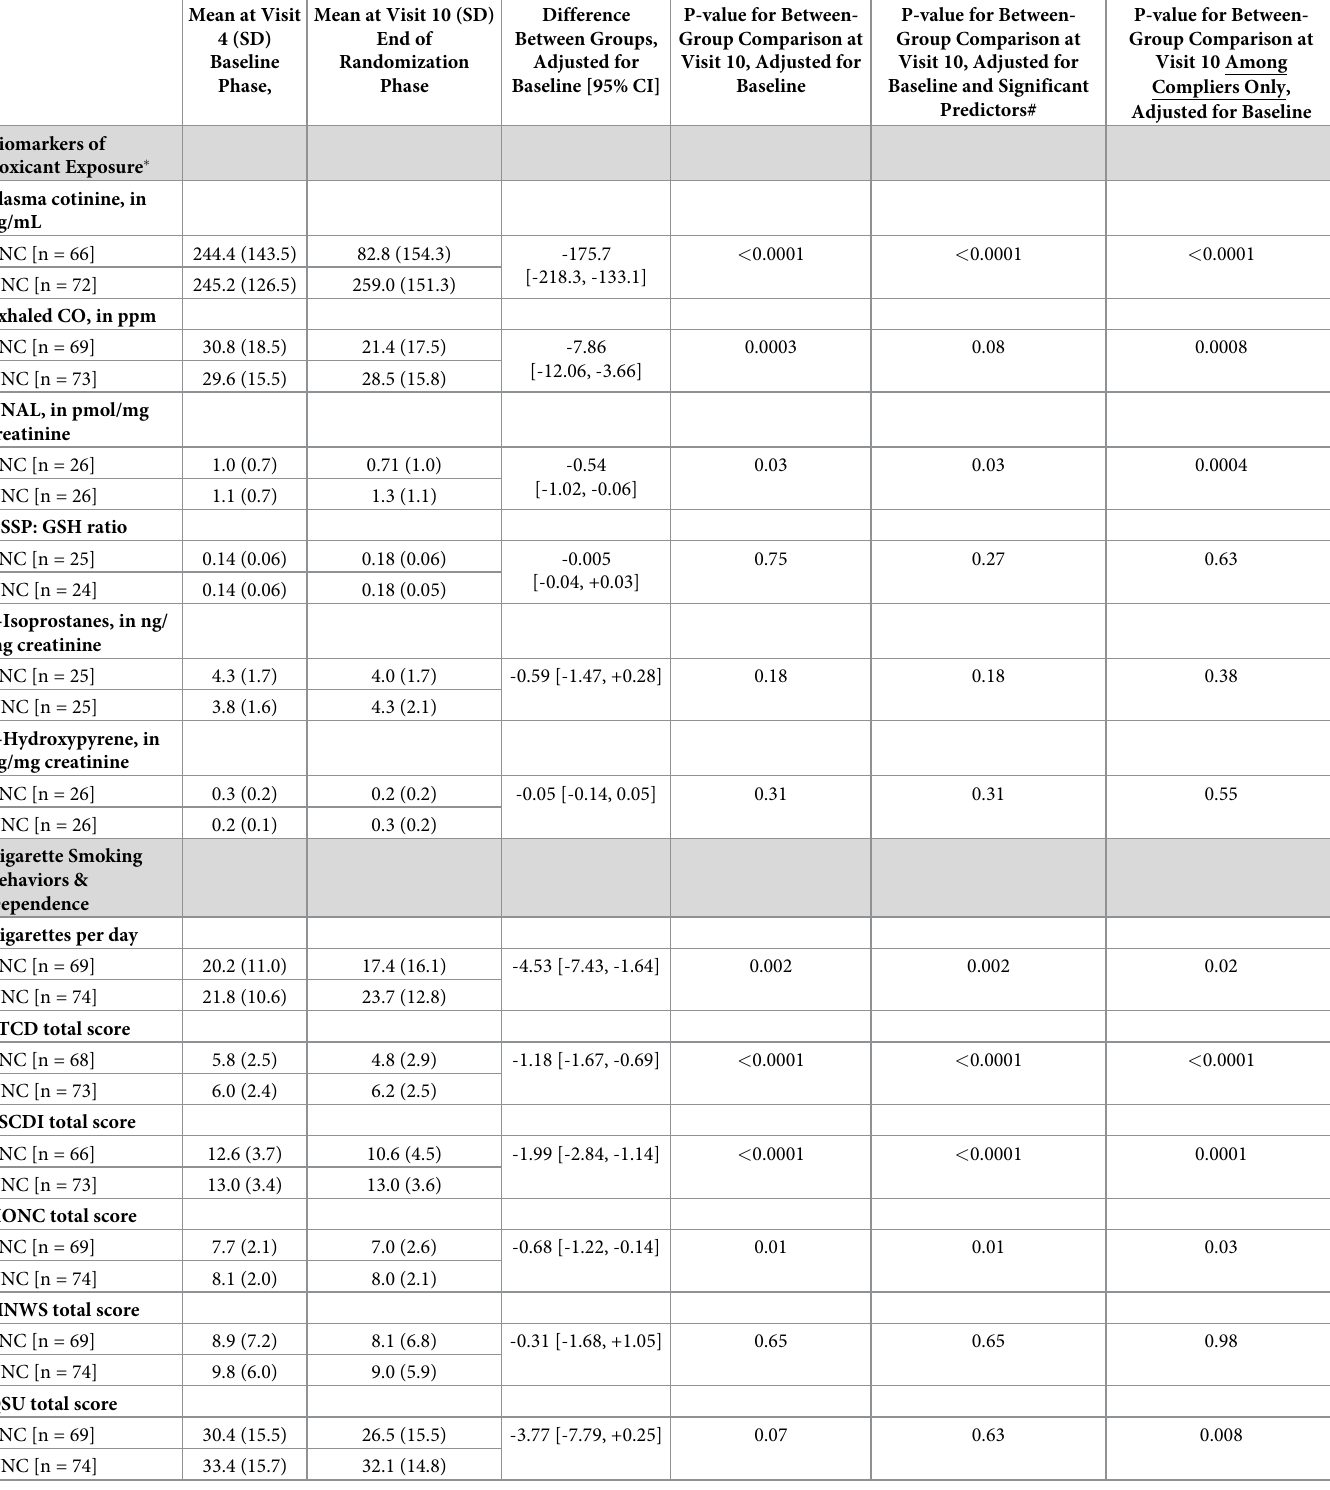
Table 2. Means at baseline (visit 4) � and end of randomized phase (visit 10) for each group and results of statistical comparisons based on linear regression models.